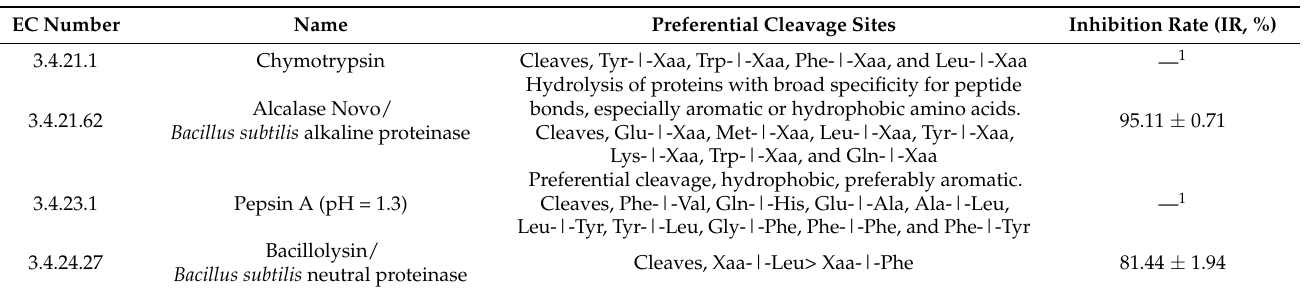
Table 1. Preferential cleavage sites of several proteinases and inhibition rate of hazelnut protein hydrolysates against oxidation of linoleic